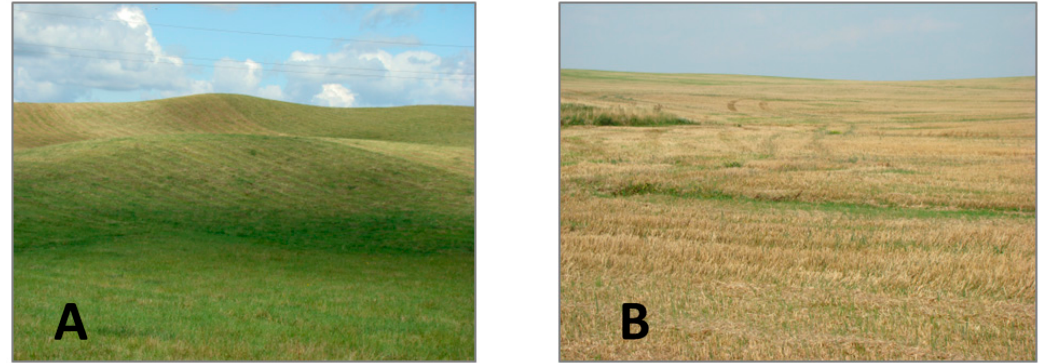
Figure 1. Location of the soil catenas.